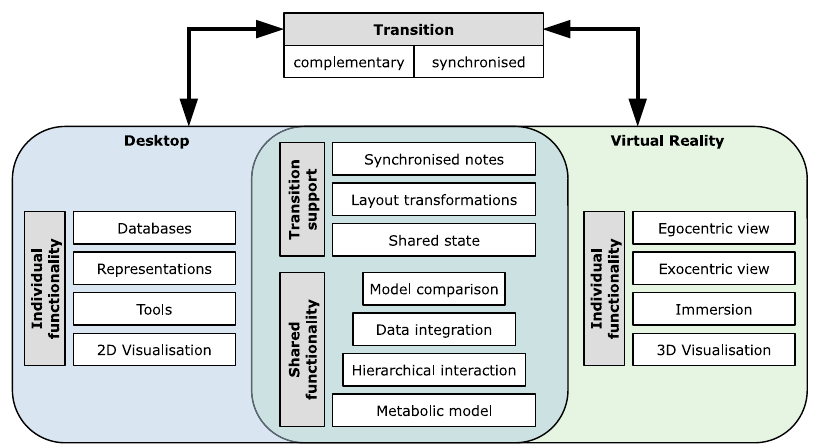
Figure 1: A schematic overview of the proposed concept for a hybrid user